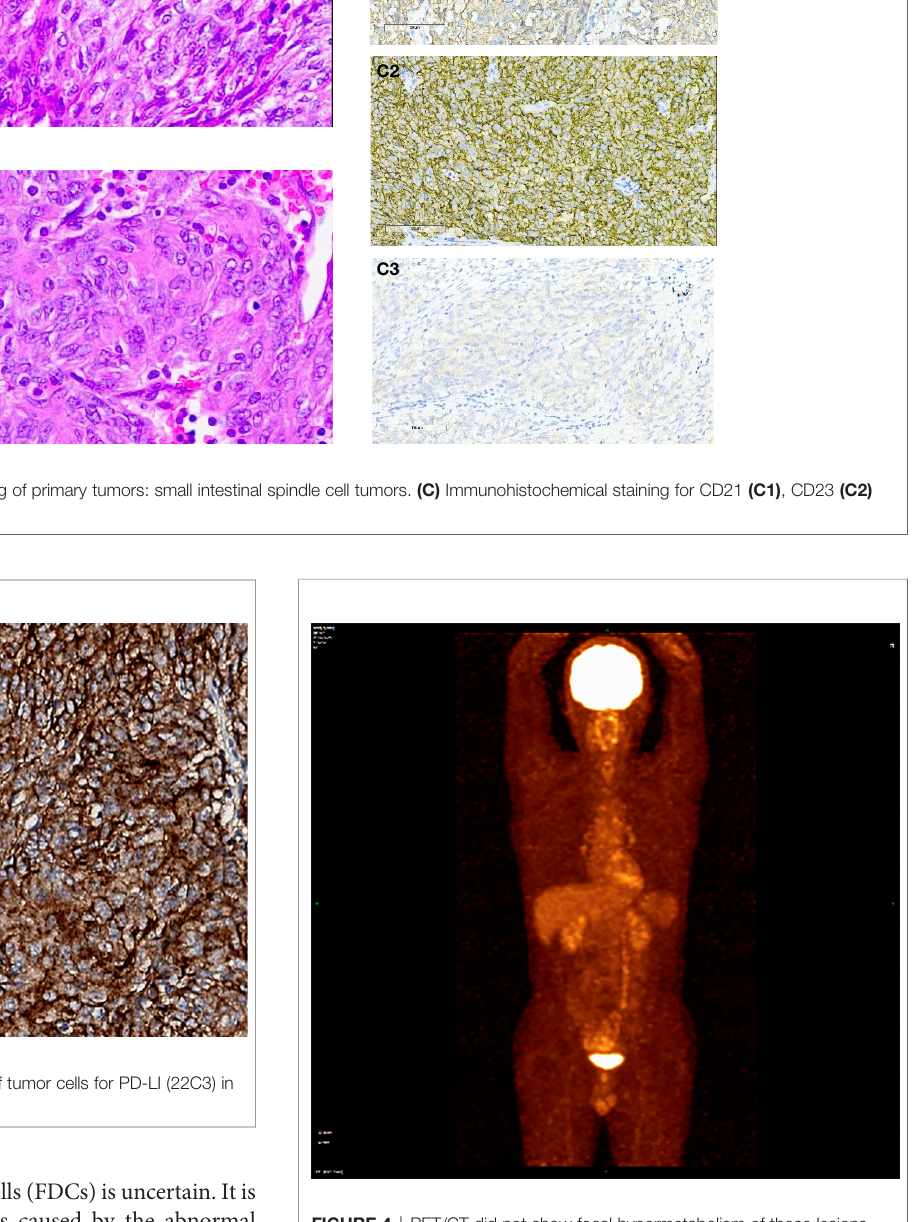
FIGURE 4 | PET/CT did not show focal hypermetabolism of those lesions corresponding to the nodules in